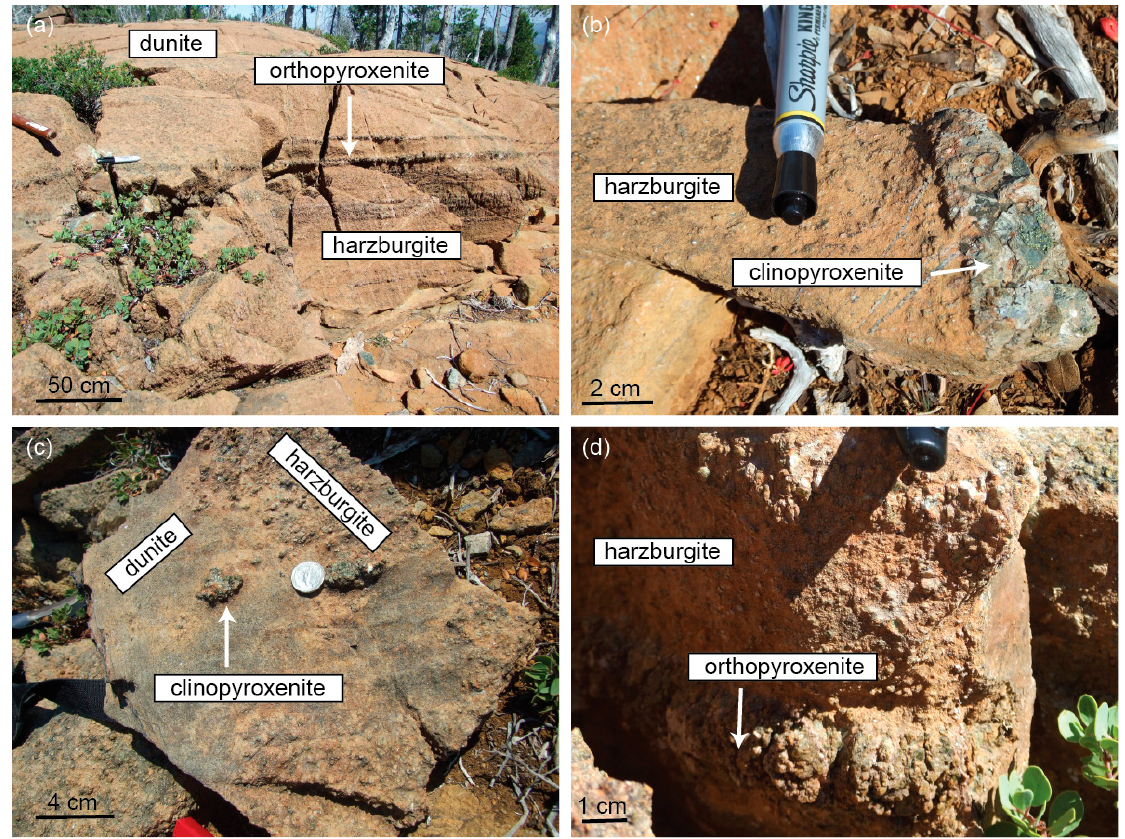
Figure 2. Field photographs of Josephine pyroxenites. ( a ) Layers of orthopyroxenite LK12-11-2A, ( b ) single large vein of clinopyroxenite LK12-6-1, ( c ) dunite cross-cutting a clinopyroxenite vein in a